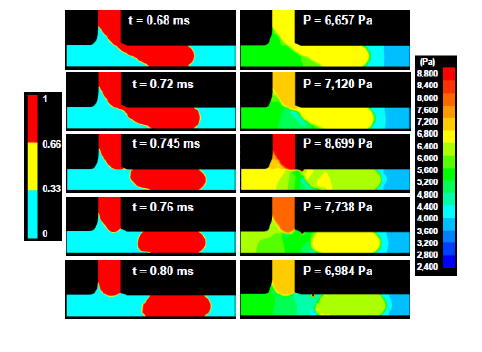
Figure 17. Gas volume fraction (left) and static pressure (right) con- tours during slug formation at